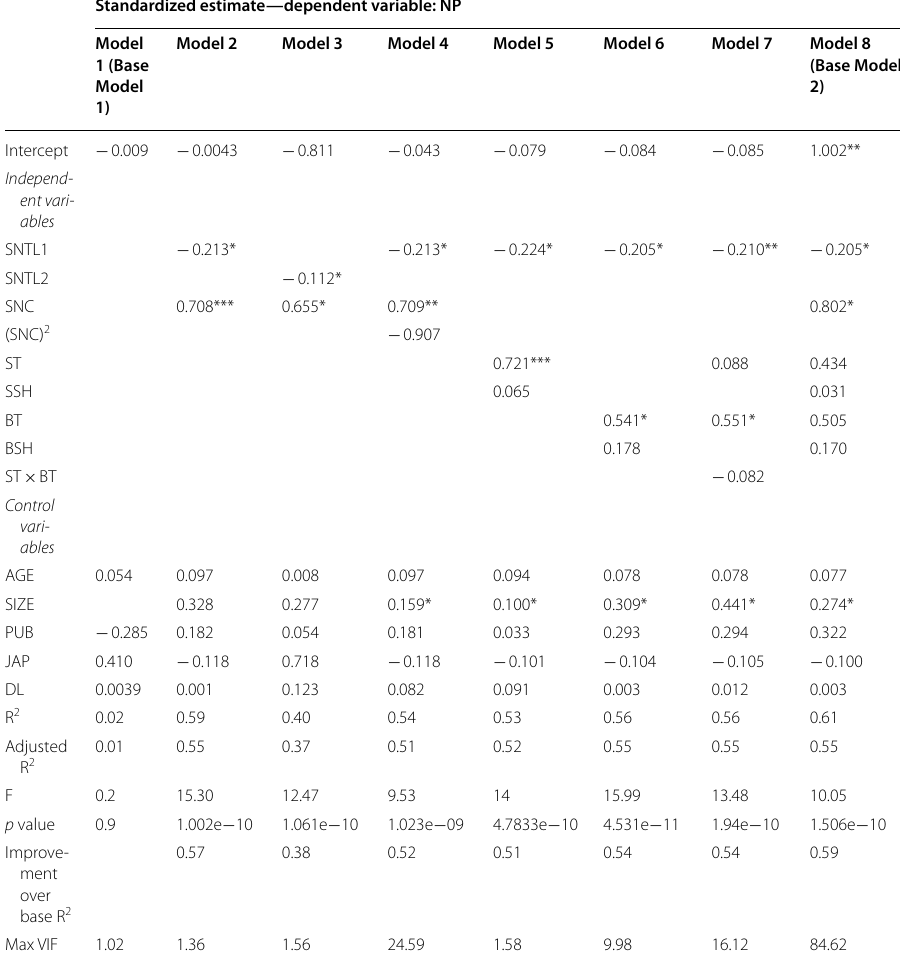
Table 5 GLS regression results—net profit Standardized estimate—dependent variable: